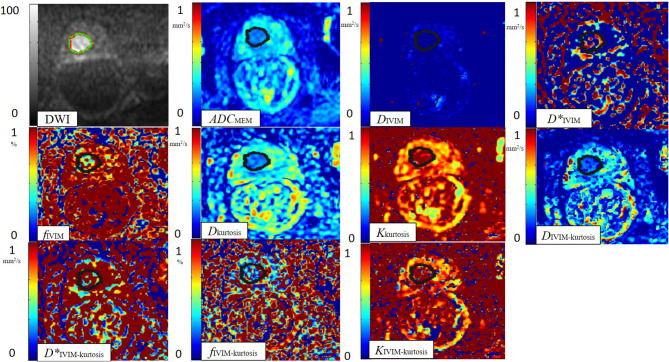
One case with PCa. A 76-year-old man with PCa (pathological GS, 3 + 4). ROI was set in PCa on DWI. ADCMEM, DIVIM, D*IVIM, fIVIM, Dkurtosis, Kkurtosis, DIVIM−kurtosis, D*IVIM−kurtosis, (j) fIVIM−kurtosis, and KIVIM−kurtosis value maps. The cancer tissue showed different signals notably from normal tissues in the DWI, ADCMEM (0.79 × 10−3 mm2/s), DIVIM (0.39 × 10−3 mm2/s), fIVIM (48.45%), Dkurtosis (1.24 × 10−3 mm2/s), Kkurtosis (0.99), DIVIM−kurtosis (0.98 × 10−3 mm2/s), and KIVIM−kurtosis (1.36) value maps. The PCa tissue seemed to be similar to normal tissues on the D*IVIM (5.53 × 10−3 mm2/s), fIVIM−kurtosis (24.09%), and D*IVIM−kurtosis (0.78 mm2/s) value maps.